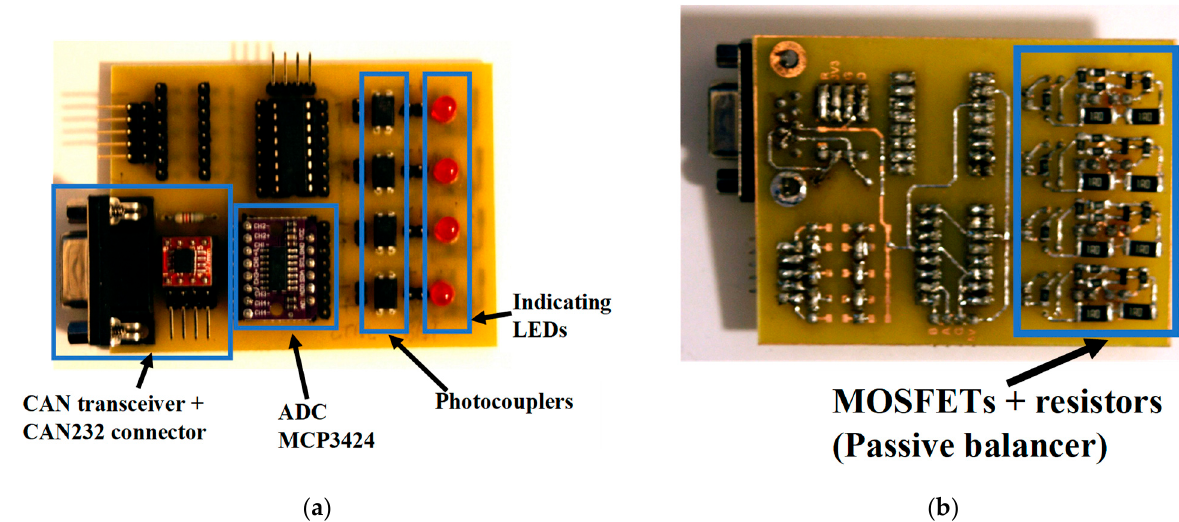
Figure 13. Prototype of Master Module: ( a ) Top side; ( b ) Bottom side.